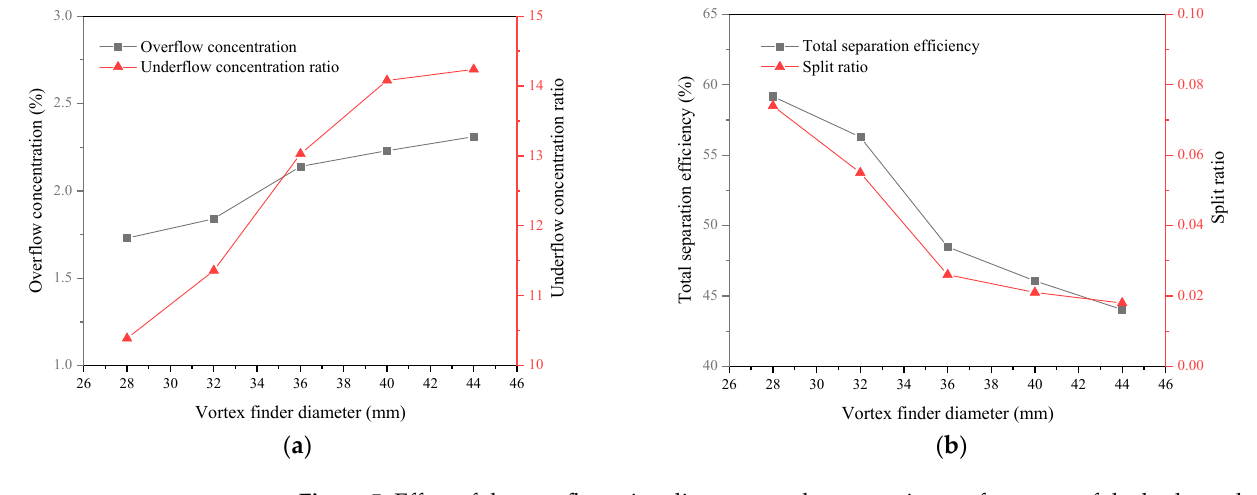
Figure 5. Effect of the overflow pipe diameter on the separation performance of the hydrocyclone. ( a ) Product concentration. ( b ) Product distribution. Table 5. Changes in the underflow concentration under different overflow pipe diameters.